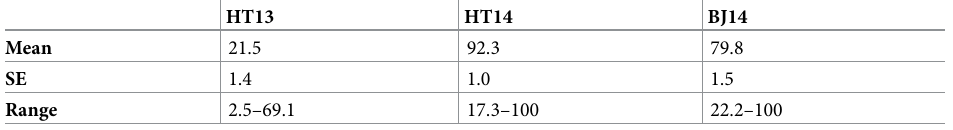
Table 5. Statistical parameters for disease severity (%) response to Septoriatritici blotch in Holeta (2013 and 2014) and Bekoji (2014), Ethiopia.